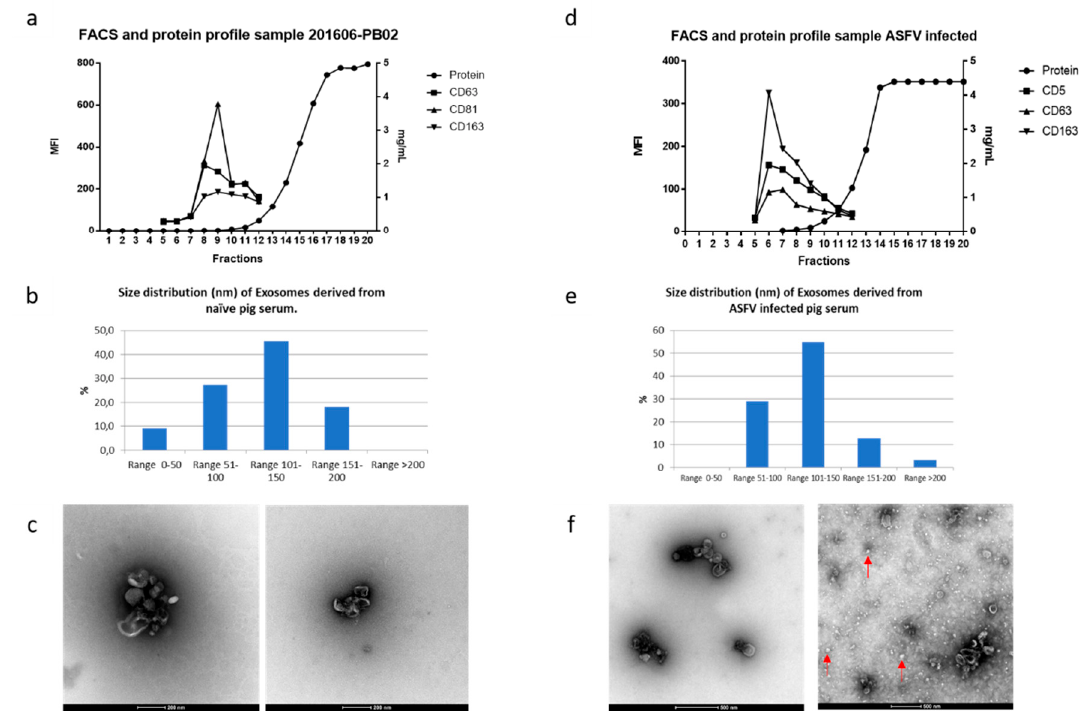
Figure 2. Characterization of extracellular vesicles derived from uninfected and ASFV infected swine sera. ( a , d ) FACS analysis of extracellular vesicle (EV) fractions derived from infected and control animals; ( b , e ) size distribution as measured by electron microscopy; ( c , f ) transmission electron microscopy of negatively-stained uninfected and infected samples, respectively. EVs are shown with red arrows (scale bar in c: 200 nm; scale bar in f: 500 nm).